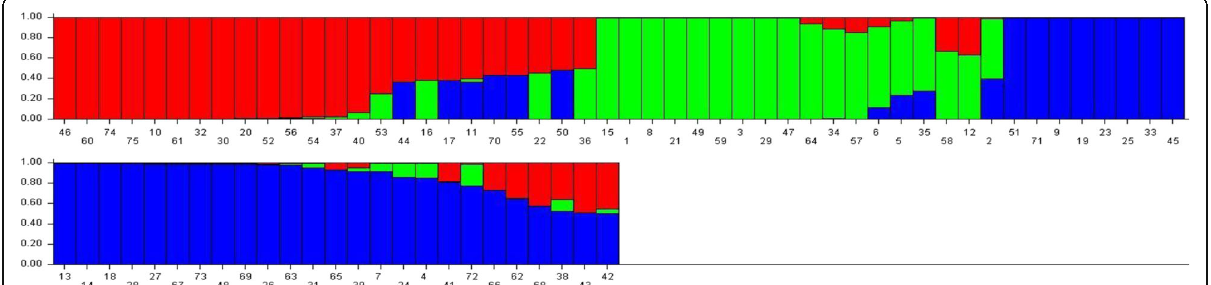
Fig. 1 Population structure of 75 accessions based on 119 SSR markers (K =